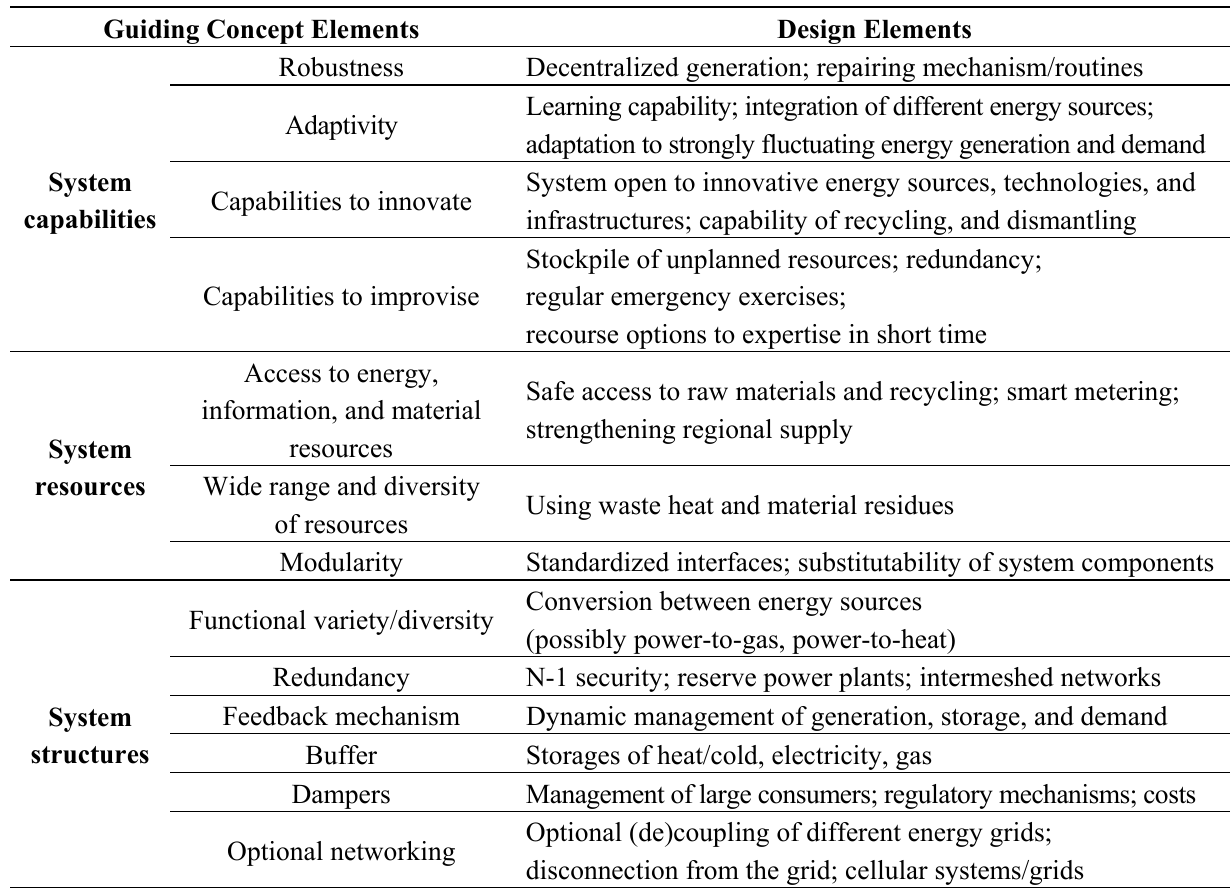
Table 1. Specification of the guiding concept of “resilient systems” into guiding concept elements and design elements using the example of the energy system based on